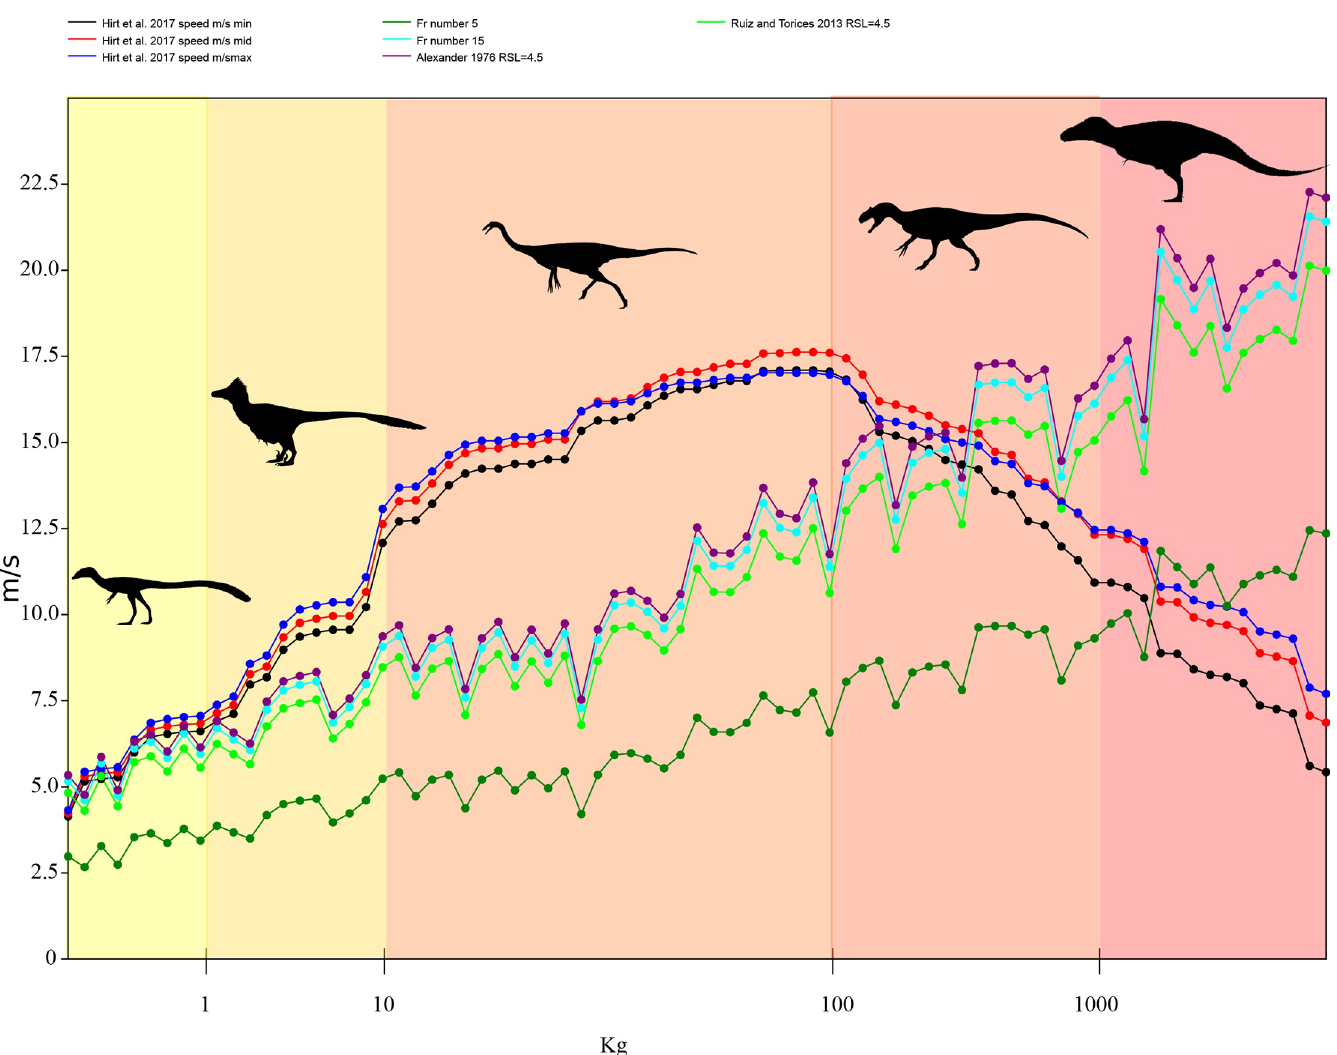
Fig 5. Pattern of maximum running speed across non-avian theropods. Observing the effect of increasing body mass on top speed in non-avian theropods by evaluating the difference between various reconstructive methods, including upper and lower confidence intervals for [7]. Note that at smaller body size, less than 100 kg, there is a large and increasing gap between the top speed limit imposed by [7] and top end estimates from other methods. This gap becomes largest in specimens between 10–100 kg indicating that perhaps these specimens had the highest ceiling to increase running speed by exaggerating hindlimb muscle size, altering insertion location, moment arm length, total leg length or stride frequency. Silhouette modified from those in Phylopic image repository (Phylopic.org) created by Joh Conway, Scott Hartman, Emily Willoughby and Matt